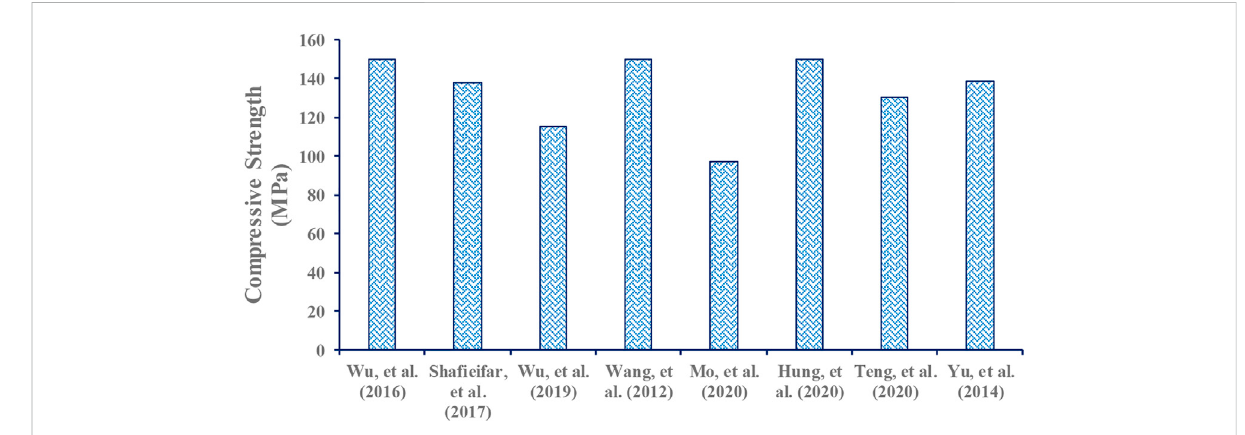
FIGURE 10 Reported compressive strengths of steel fi ber-reinforced UHPC.